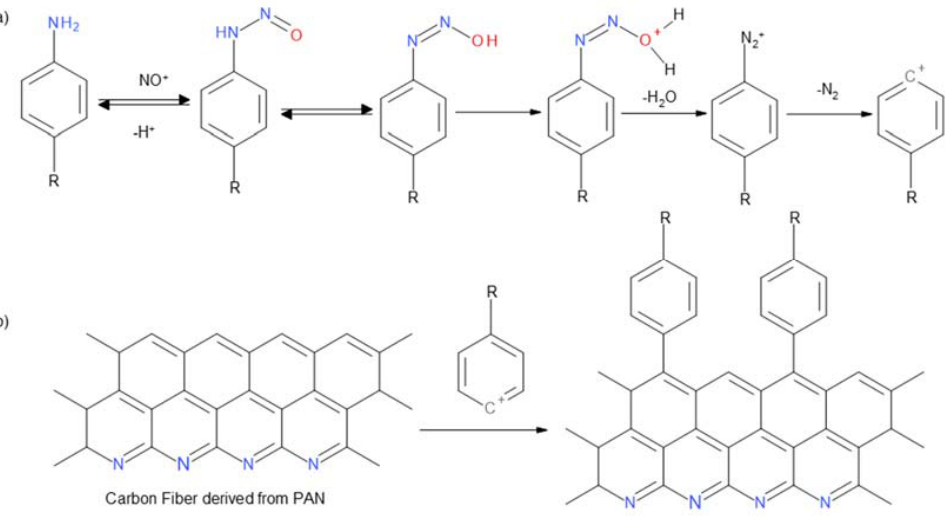
Figure 3. ( a ) Benzoic cation generation reaction; ( b ) coupling reaction to the surface of materials containing carbon atoms with Csp 2 configuration.